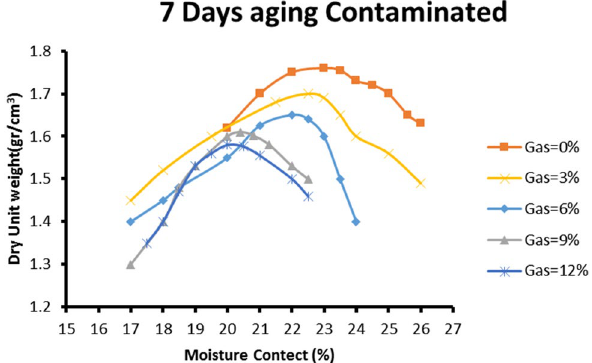
Fig. 13 Maximum dry density changes in 30-day contamination and different percentages of gasoline